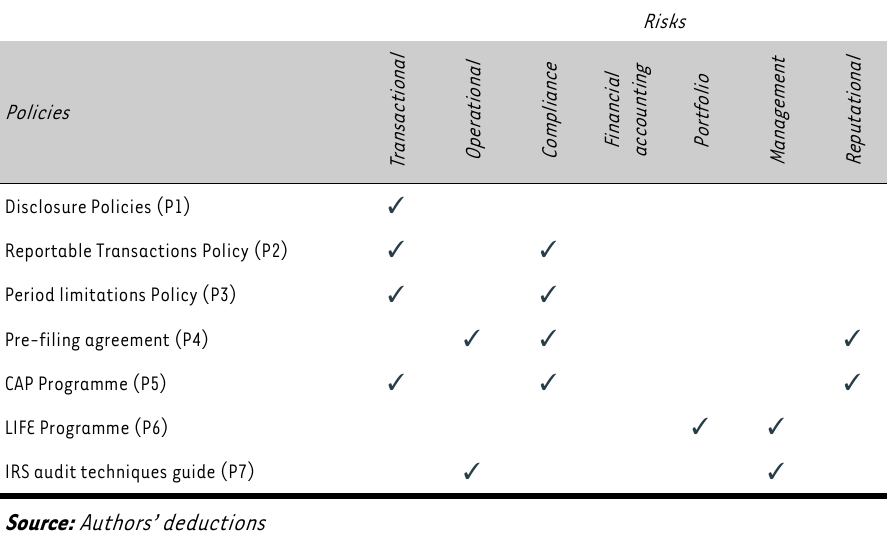
TABLE 1: TRM programmes in the USA